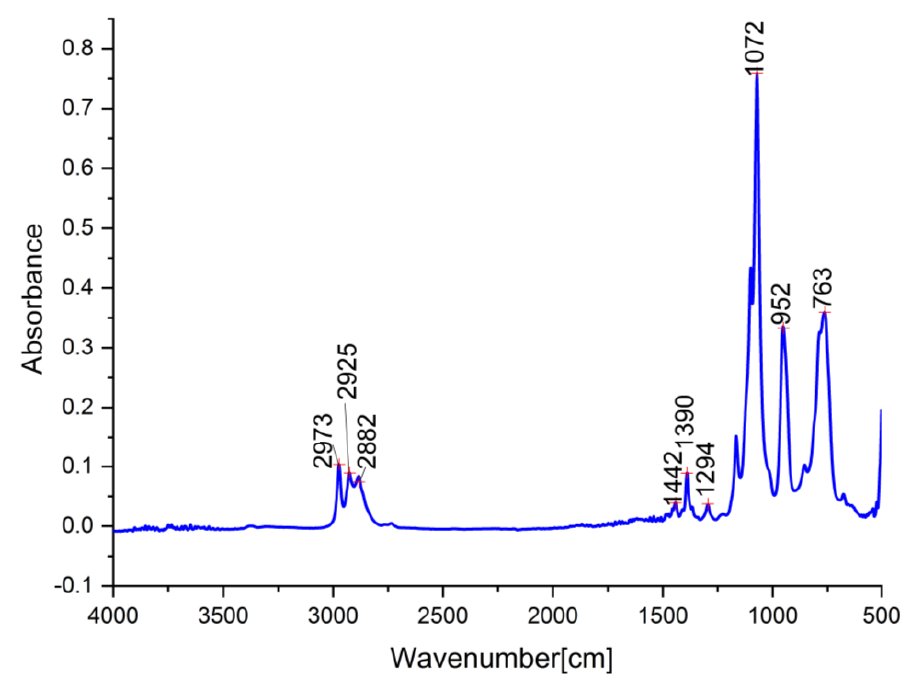
Figure 1. FT-IR spectra of silane (APTES).